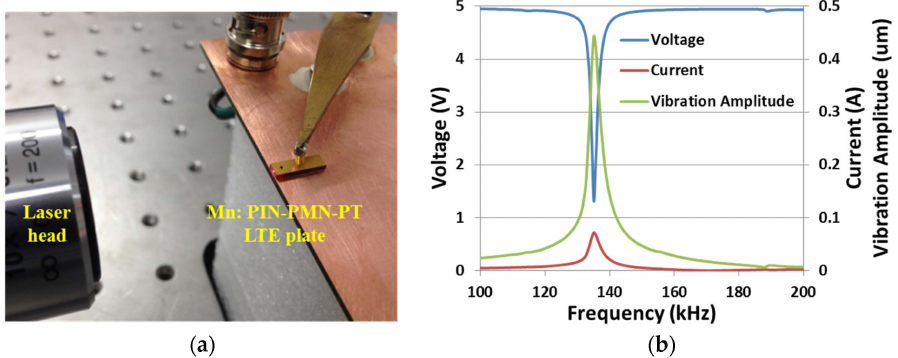
Figure 11. ( a ) Laser vibrometry characterisation setup with a Mn:PIN-PMN-PT LTE plate with ( b ) responses of voltage, current, and vibration amplitude when a constant AC 5 V driving voltage was swept from 100 to 200 kHz.